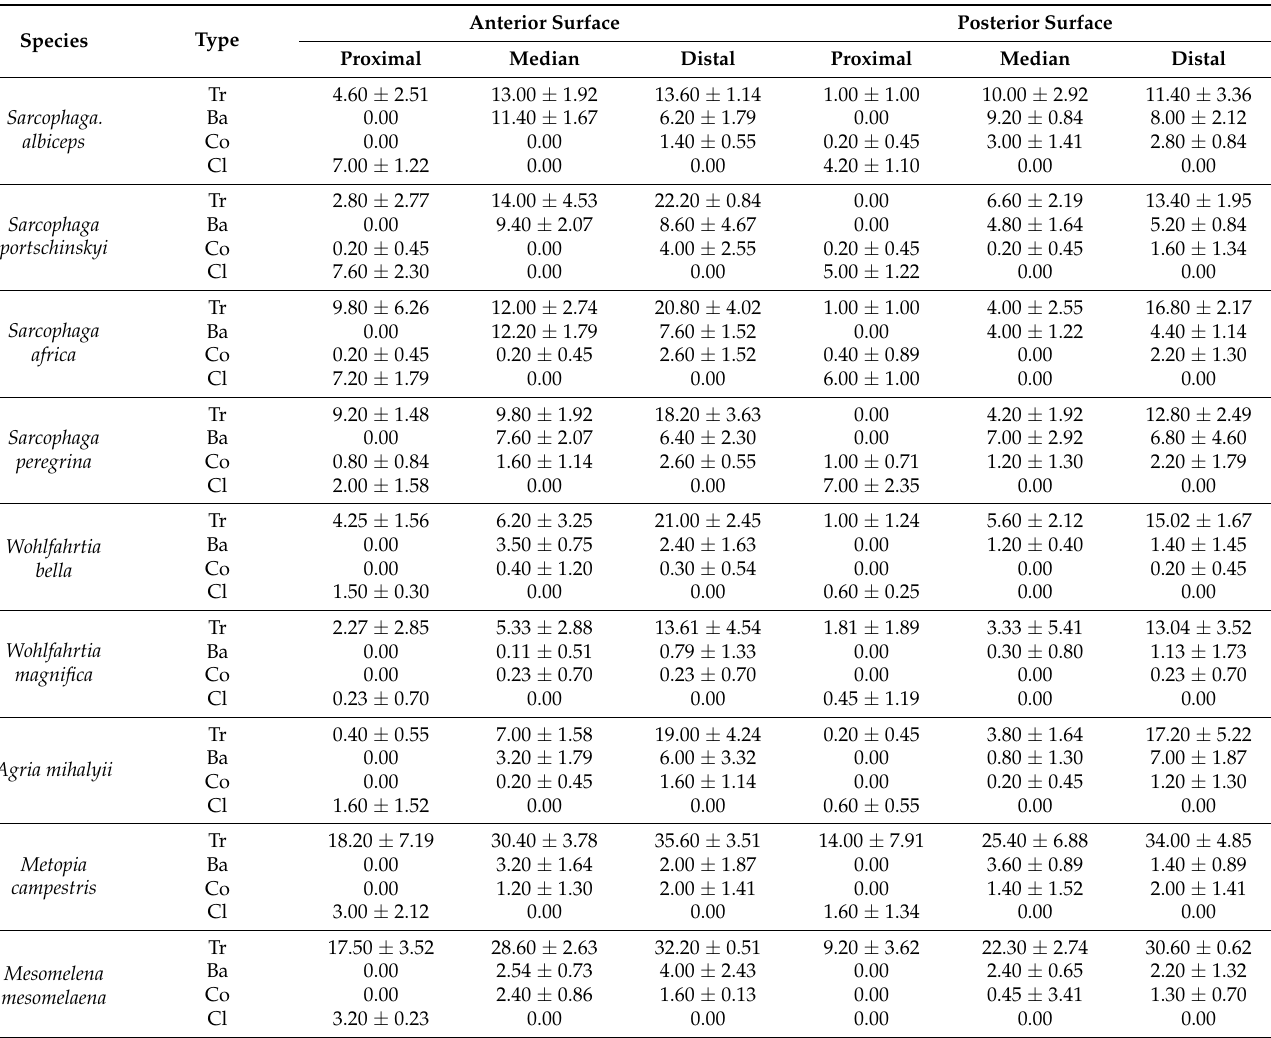
Table 3. Average density of sensilla on the antennal postpedicel of nine male sarcophagid species (10 − 3 µ m − 2 ± SD, n = 20). Abbreviations: Ba (basiconic sensilla); Cl (clavate sensilla); Co (coeloconic sensilla); Tr (trichoid sensilla). The proximal, median, and distal regions each consist of one-third of the antenna in